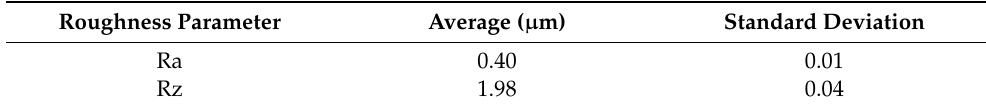
Table 2. Unpolished Al6082 aluminium surface roughness: values are intended as an average of 5 measurements.